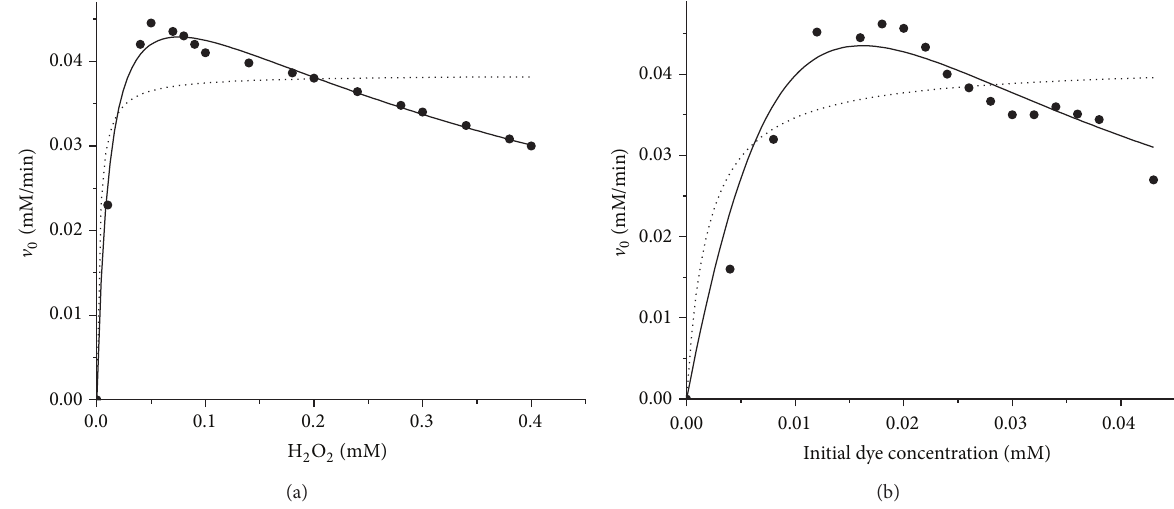
Figure 7: (a) Initial rate versus hydrogen peroxide concentration at fixed AV 109 concentration of 0.018 mM and (b) initial rate versus AV 109 concentration at fixed hydrogen peroxide concentration of 0.06 mM. Symbols represent experimental data, lines indicate kinetic models based on fitted kinetic parameters including substrate inhibition (solid lines) and without substrate inhibition (dotted lines).